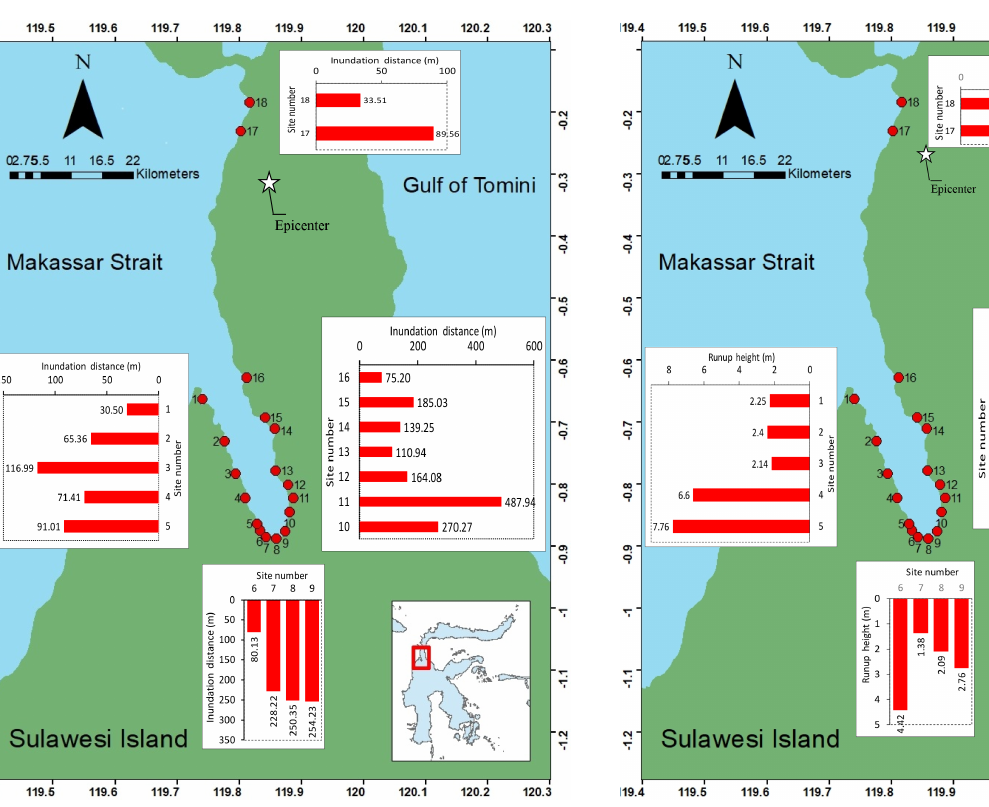
Figure 3. Measurement results of inundation distances. Figure 4. Measurement results of run-up